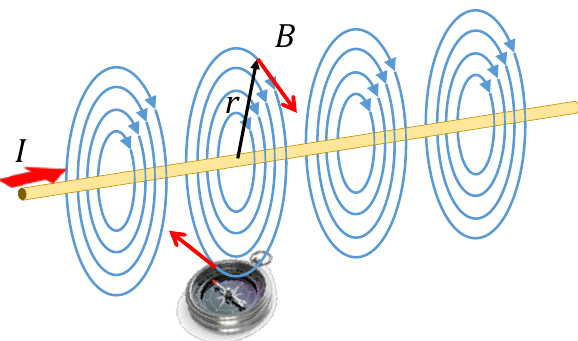
Figure 14. Magnetic field force lines generated by a rectilinear con- ductor carrying a constant electric current